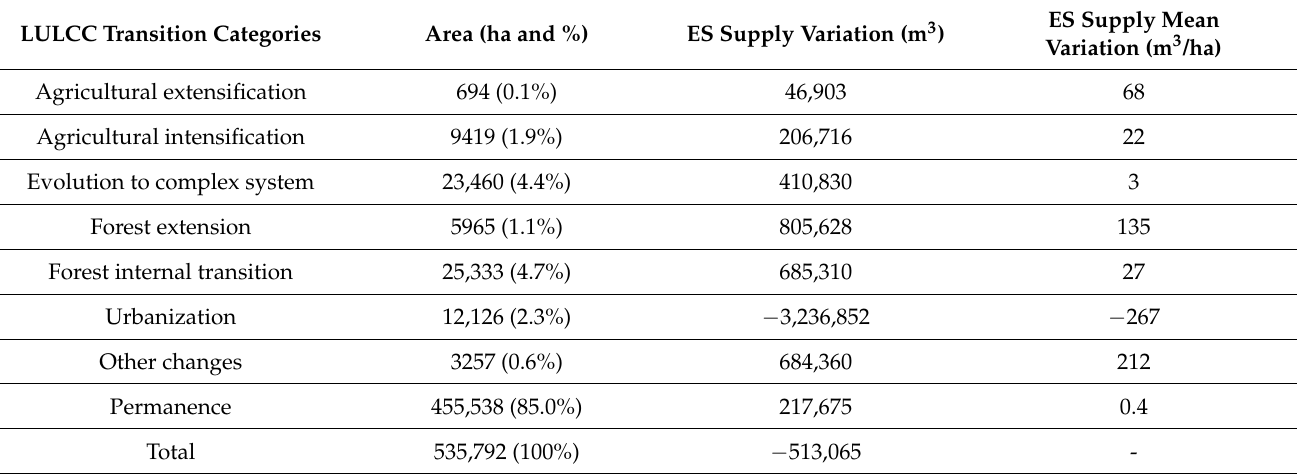
Table 1. Total and average change in ES flood mitigation supply for each LULC transition